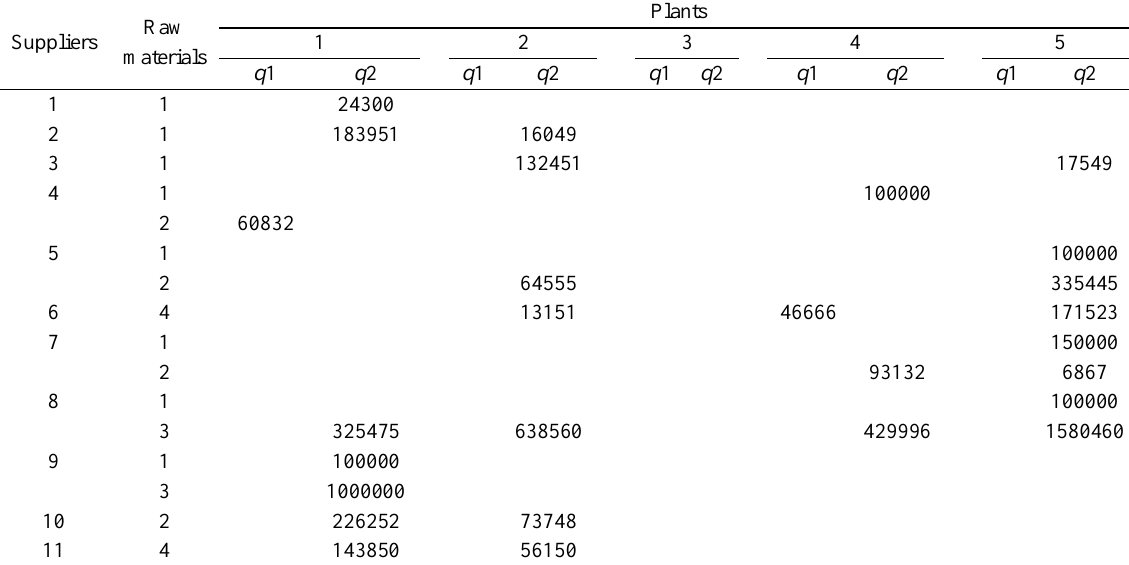
Table 11. Supplier selection and order